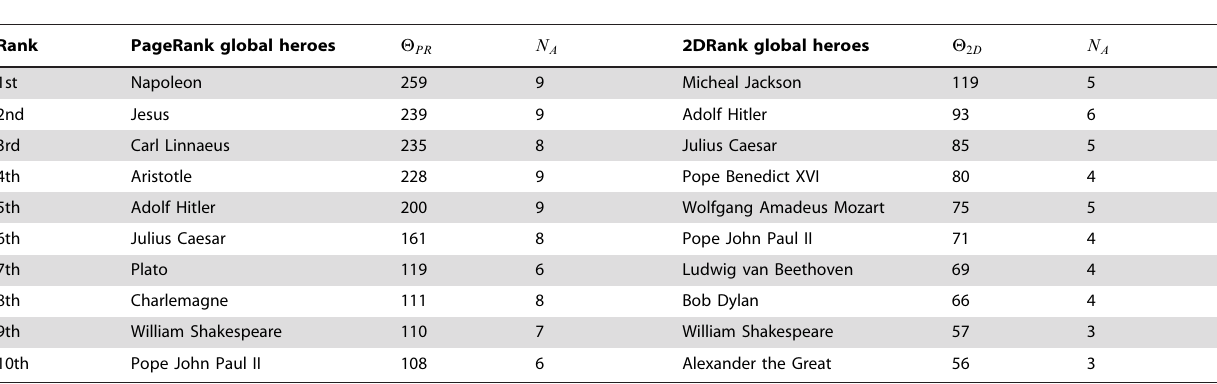
Table 7. List of global heroes by PageRank and 2DRank for all 9 Wikipedia